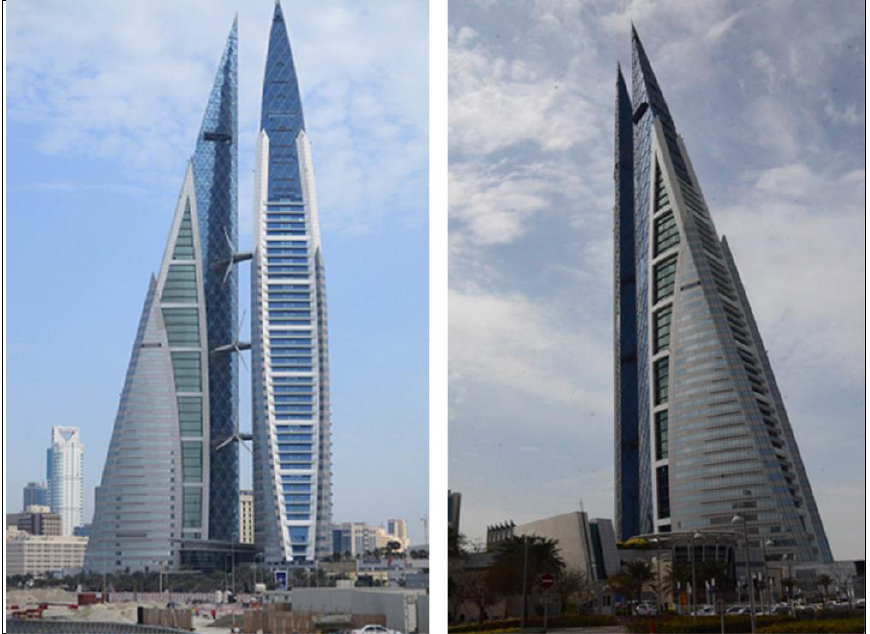
Figure 24. Bahrain World Trade Center (photographs by authors).